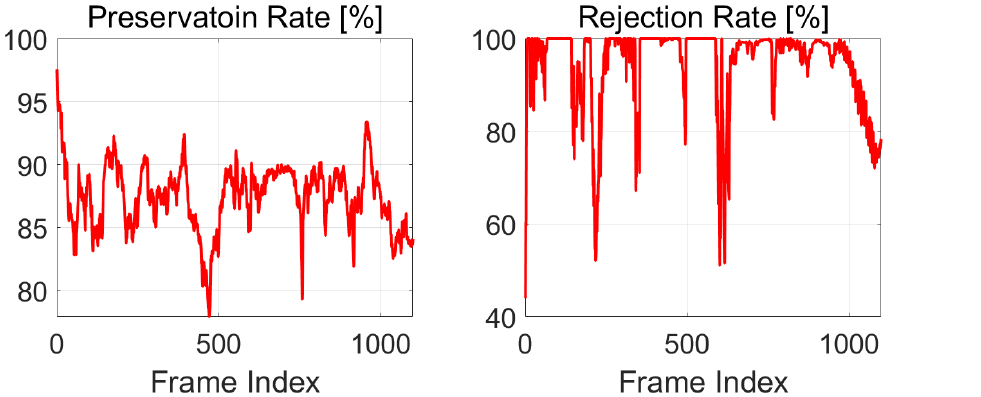
Figure 9. The preservation rate and rejection rate calculated for each of the 1100 frames in Semantic KITTI sequence 07